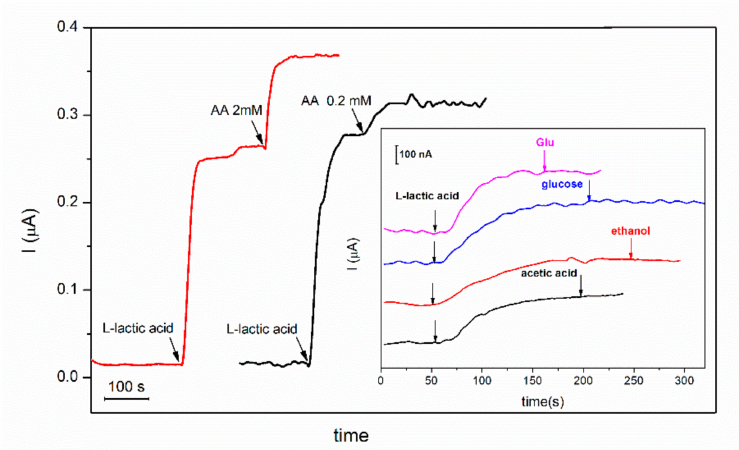
Figure 8. Biosensors response to successive addition of L-lactic acid 2 mM and ascorbic acid (AA) 2 mM (red line) and 0.2 mM (black line), respectively (inset: biosensor response to successive addition of L-lactic acid 2 mM and acetic acid, ethanol and glucose and glutamic acid (Glu) 0.2 mM; E = +500 mV, [NAD + ] = 8 mM, PBS 0.1 M pH = 7.5). Table 2. Influence of interfering compounds on the detection of lactic acid. Interfering